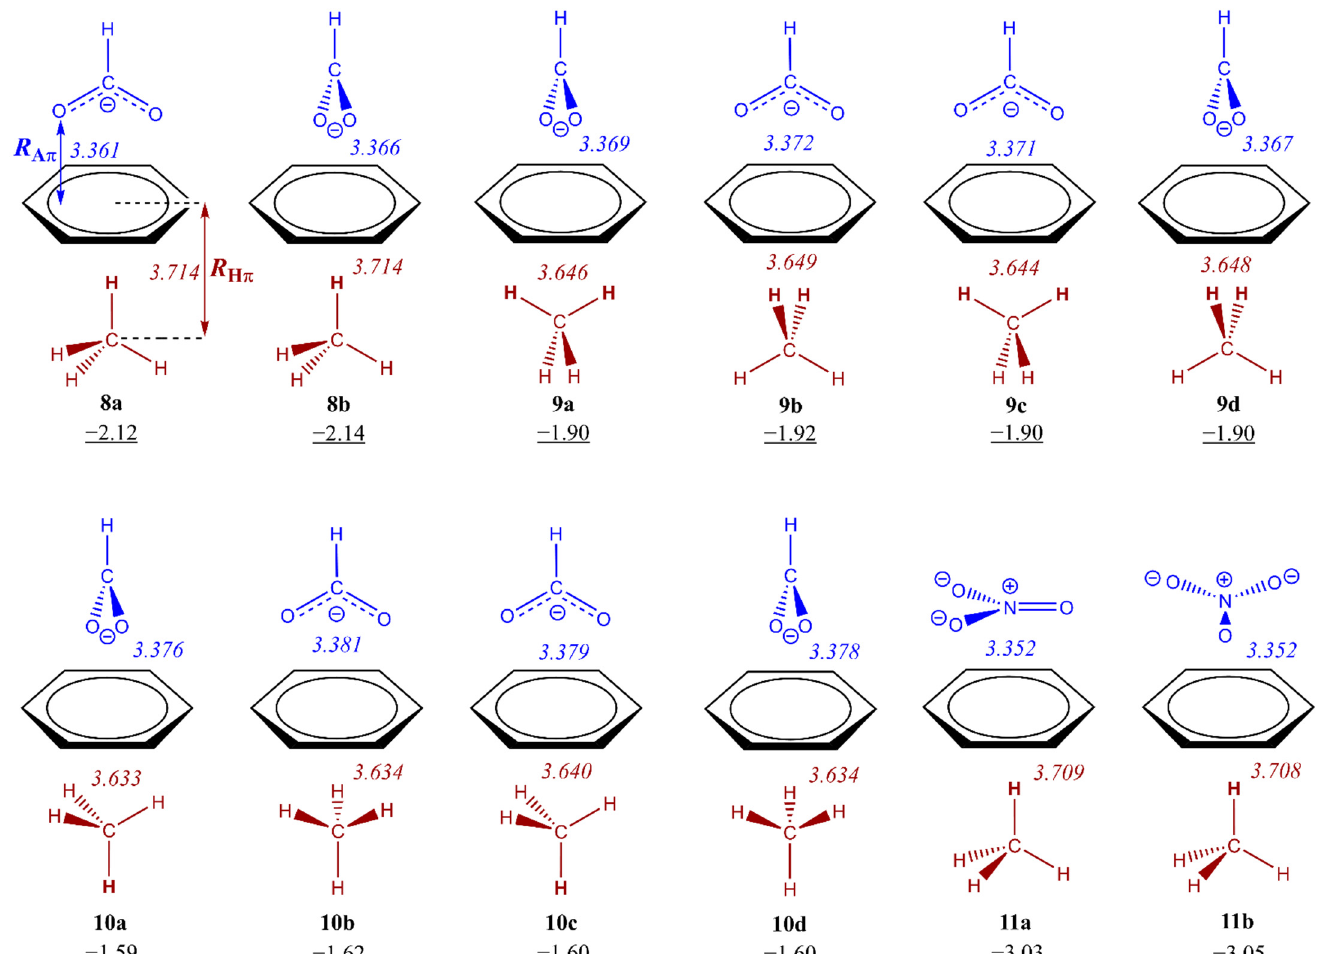
Figure 2. CH/ π –anion complexes ( 8 – 11 ) under study. Binding energies (in kcal/mol) are underlined, and equilibrium distances (in Å ) are shown in italics. and equilibrium distances (in Å) are shown in